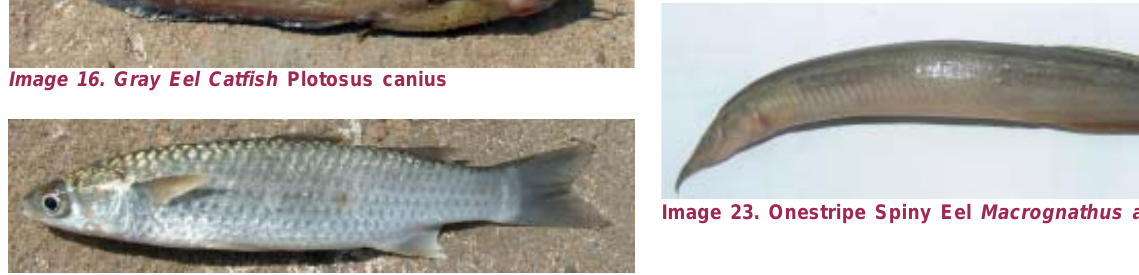
Image 17. Common or Flathead Mullet Mugil cephalus